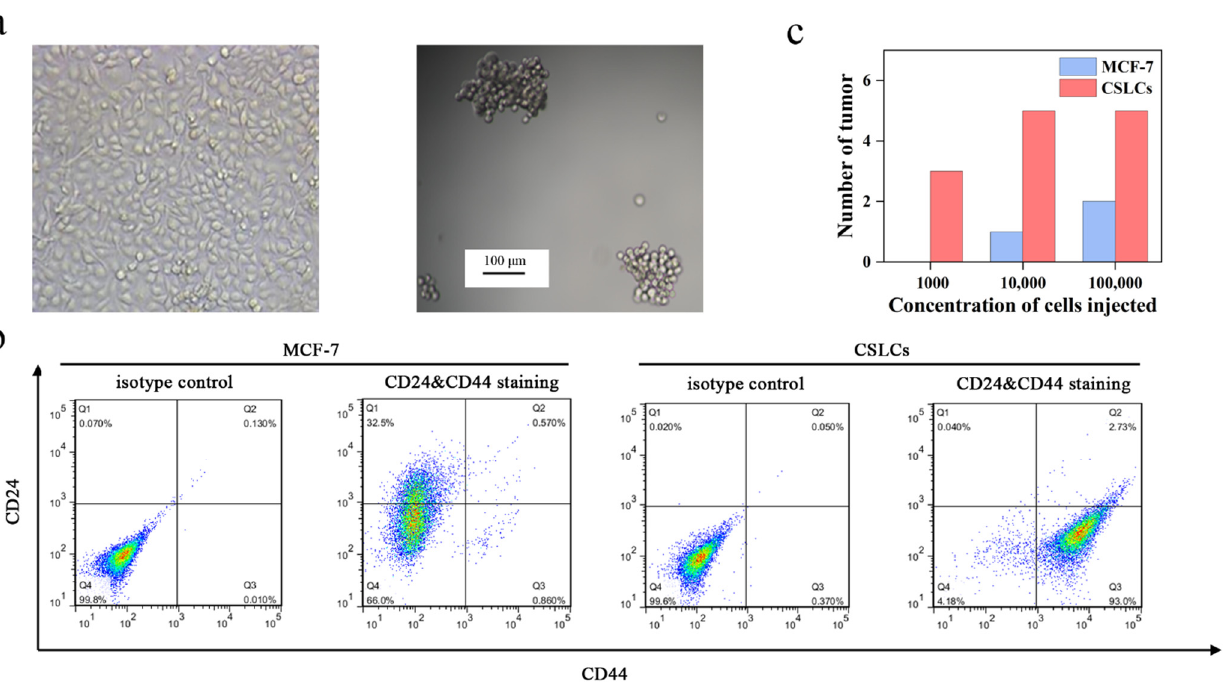
Figure 3. ( a ) Image of MCF-7 and CSLCs under the light microscope. ( b ) Identification of phenotype for MCF-7 and CSLCs stained with IgG-FITC and IgG-PE antibodies as isotype control and stained with anti-CD44-FITC and anti-CD24-PE antibodies. ( c ) The tumorigenic ability of MCF-7 and CSLCs transplanted into female nude mice.